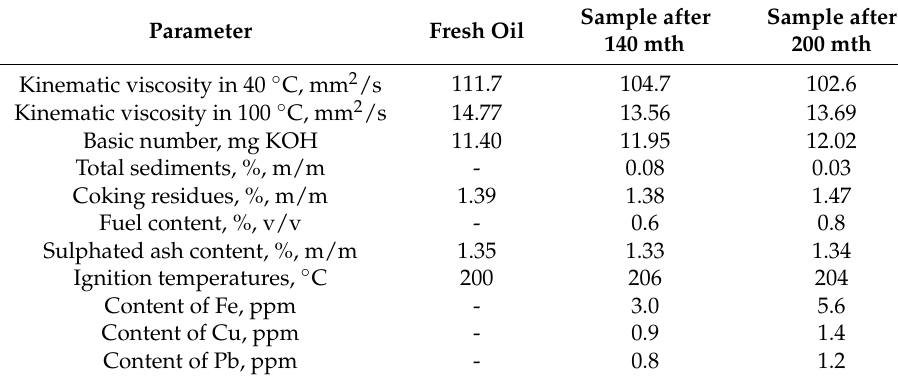
Table 2. Results of engine oil